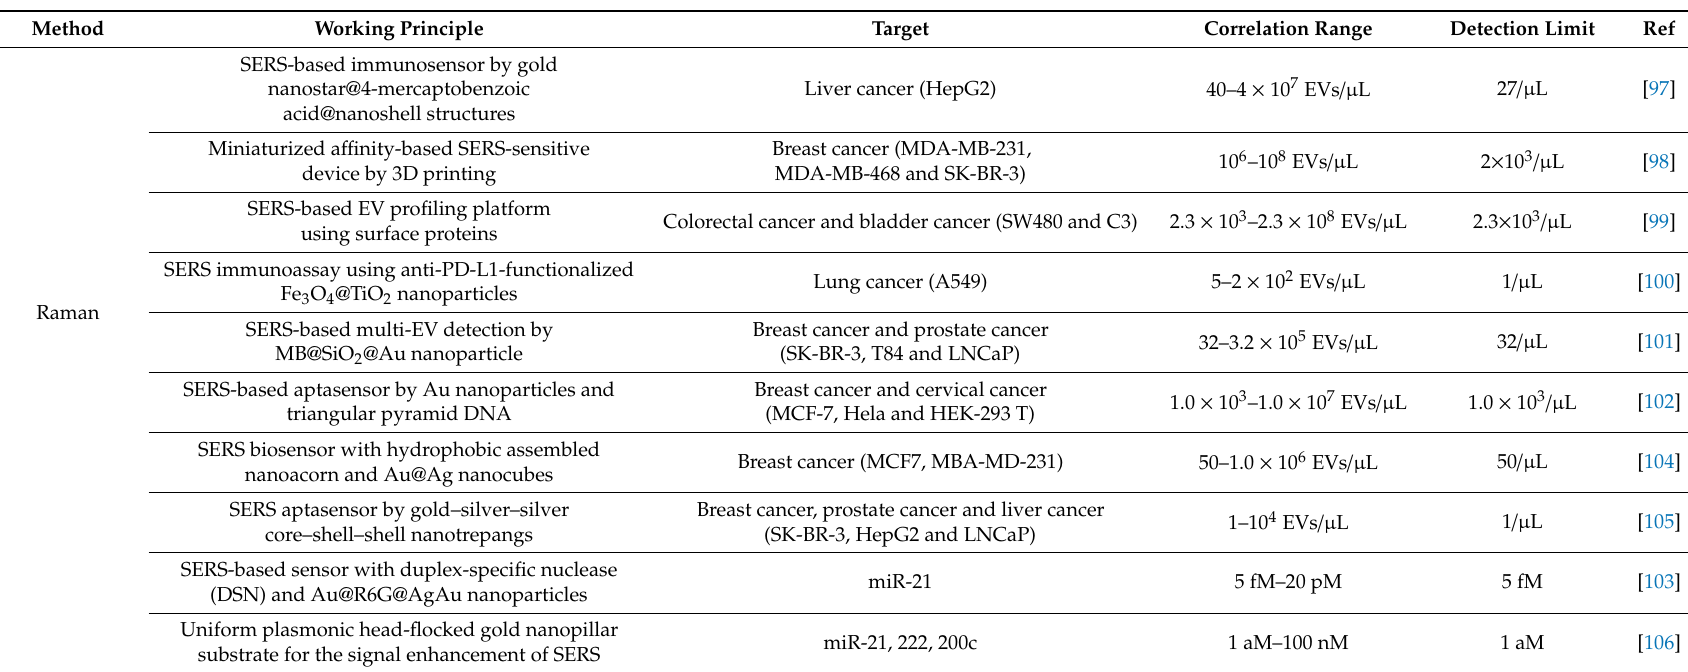
Table 4. Comparison of Raman-Based Bionano Sensors for EV